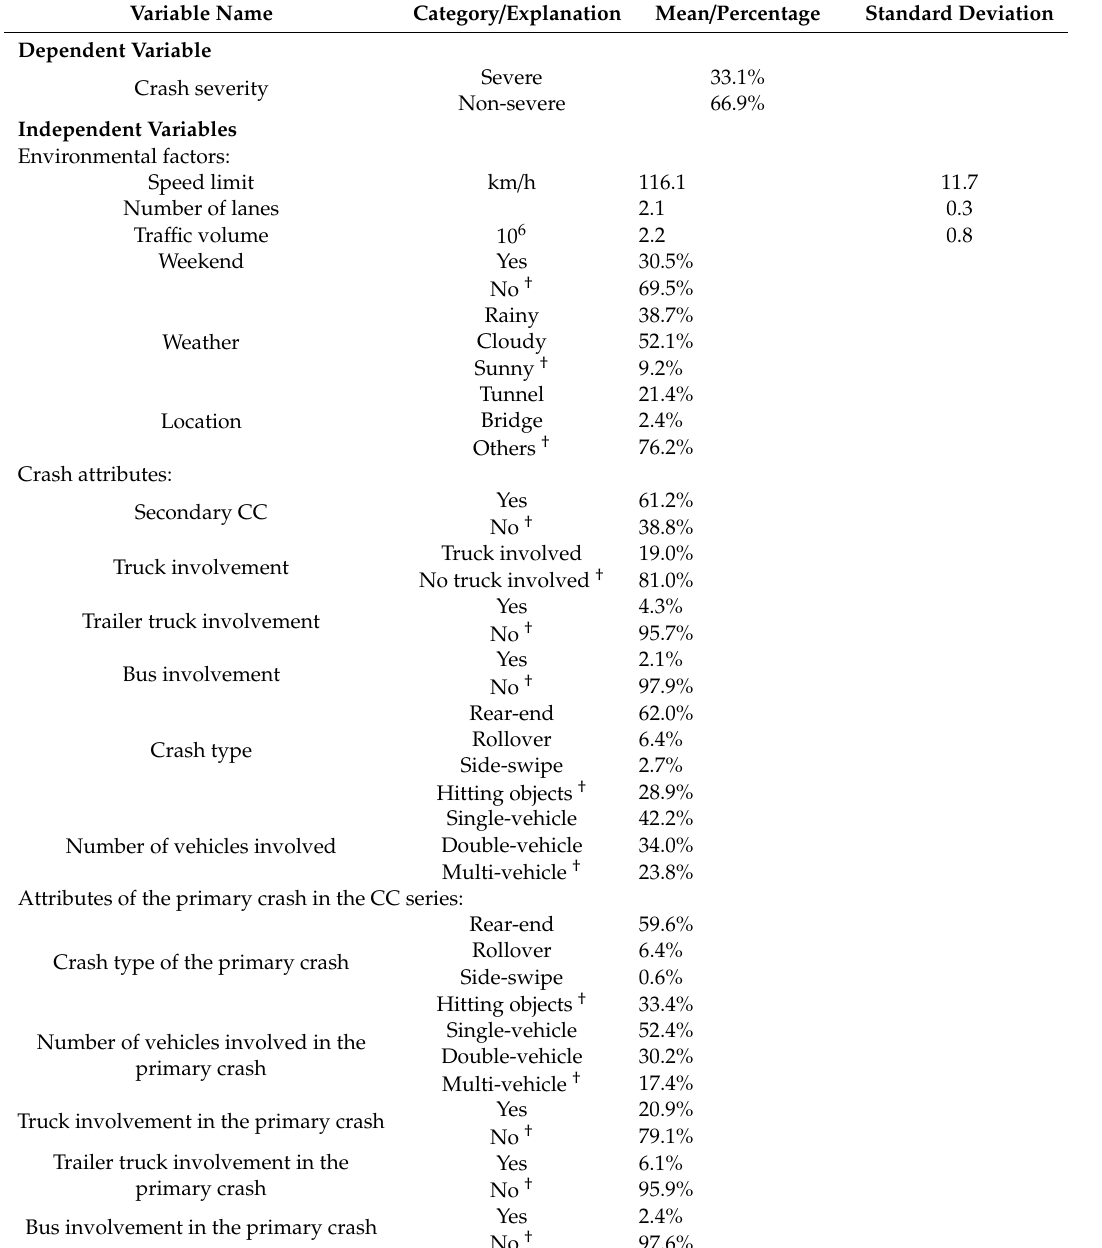
Table 1. Descriptive statistics of dependent and independent